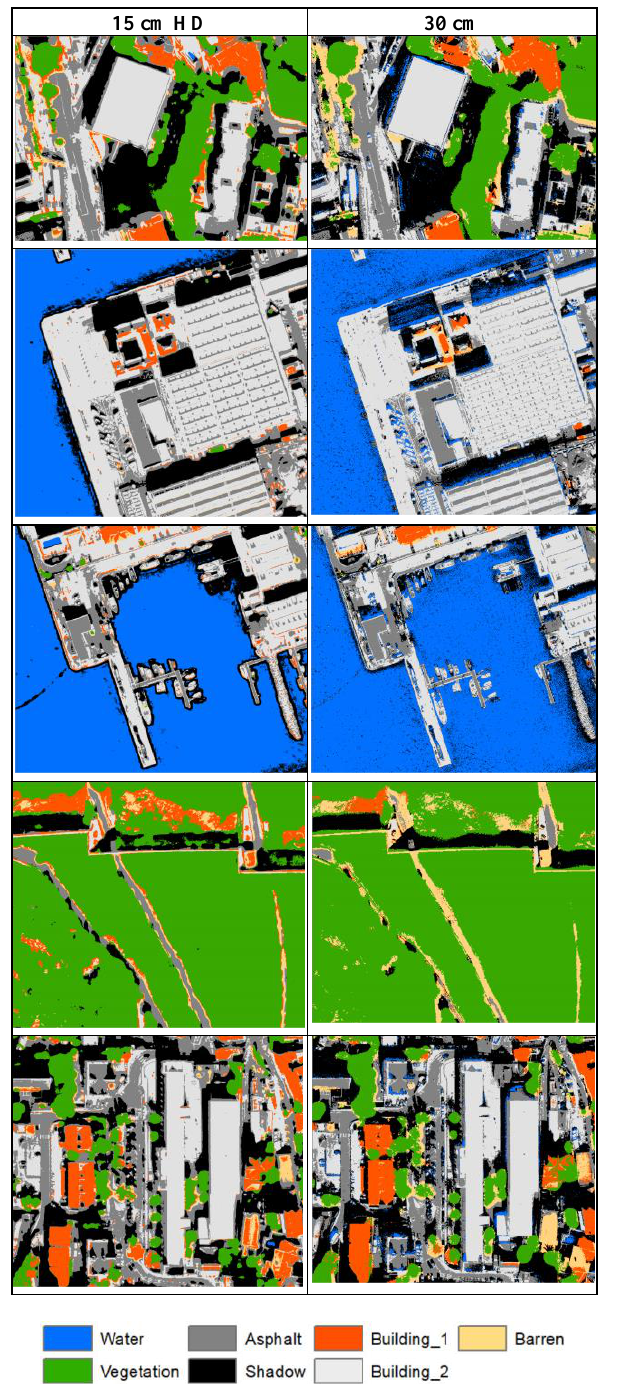
Figure 11. Image parts containing 15 cm HD and 30 cm SVM model results in the Gibraltar region